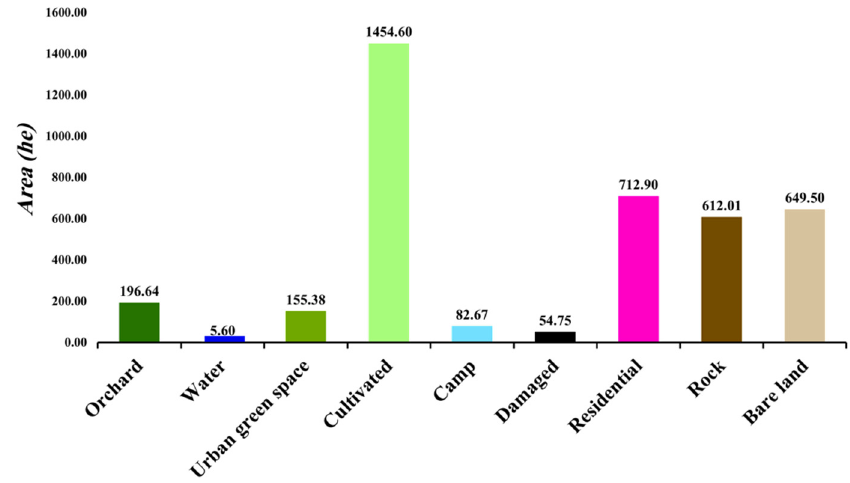
Figure 9. Area of obtained classes.